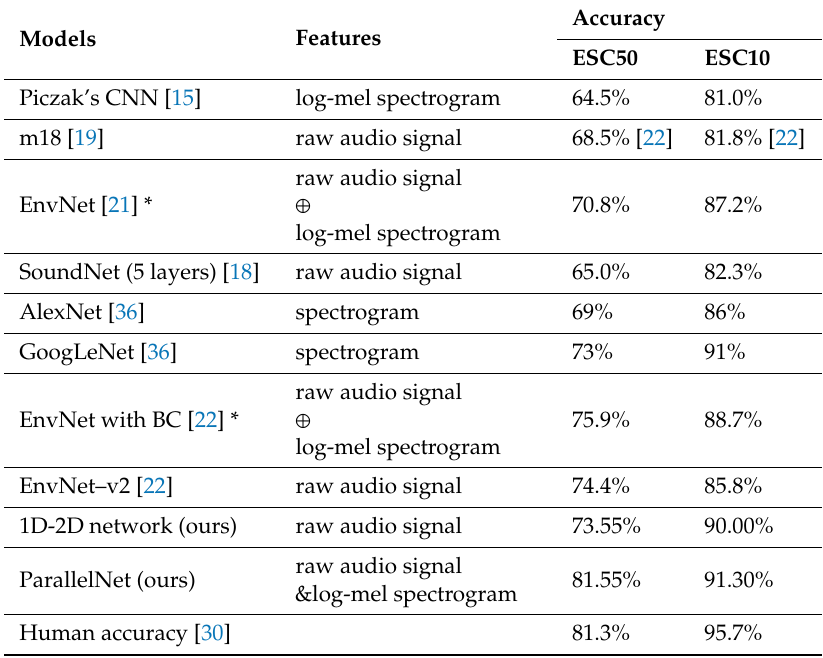
Table 11. Test result of di ff erent kinds of models with